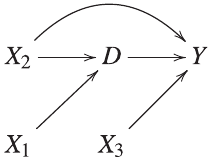
Figure 1: Covariate types: Type-I: X 1 , Type-II: X 2 and Type-III: X 3